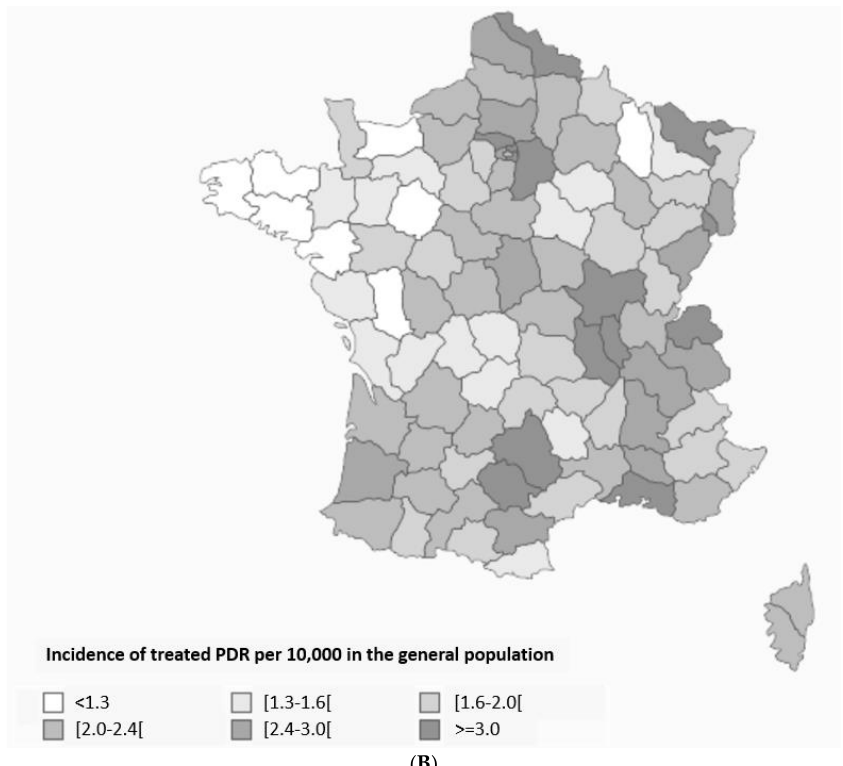
Figure 3. Treated DME ( A ) and PDR ( B ) incidence in the general population in 2018 per region in France. Abbreviations: DME = diabetic macular edema, PDR = proliferative diabetic retinopathy. Incidence in the corresponding population in France aged ≥18 years, expressed per 100 inhabitants.